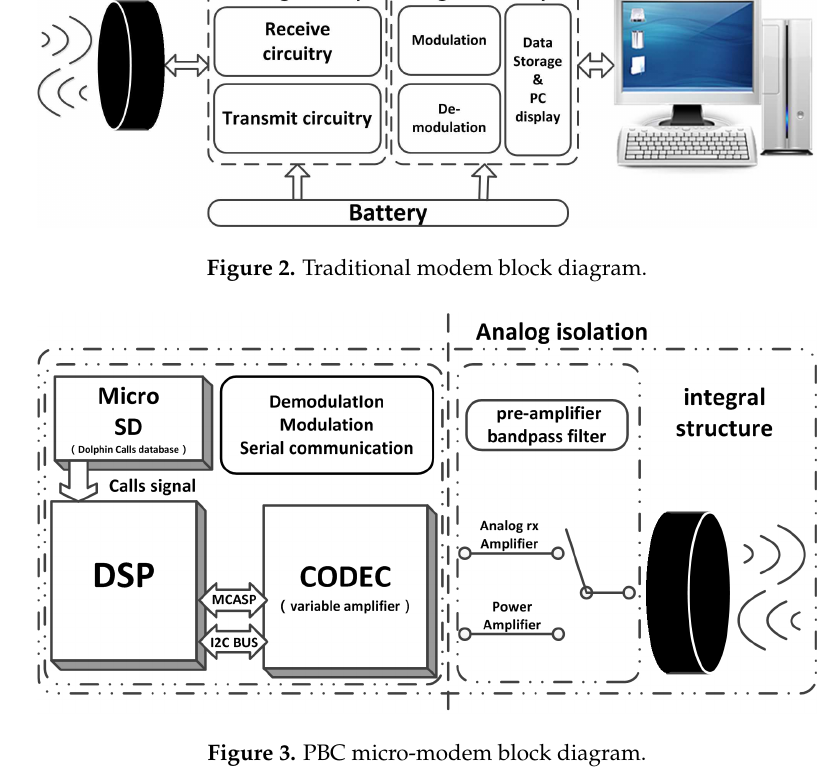
Figure 3. PBC micro-modem block